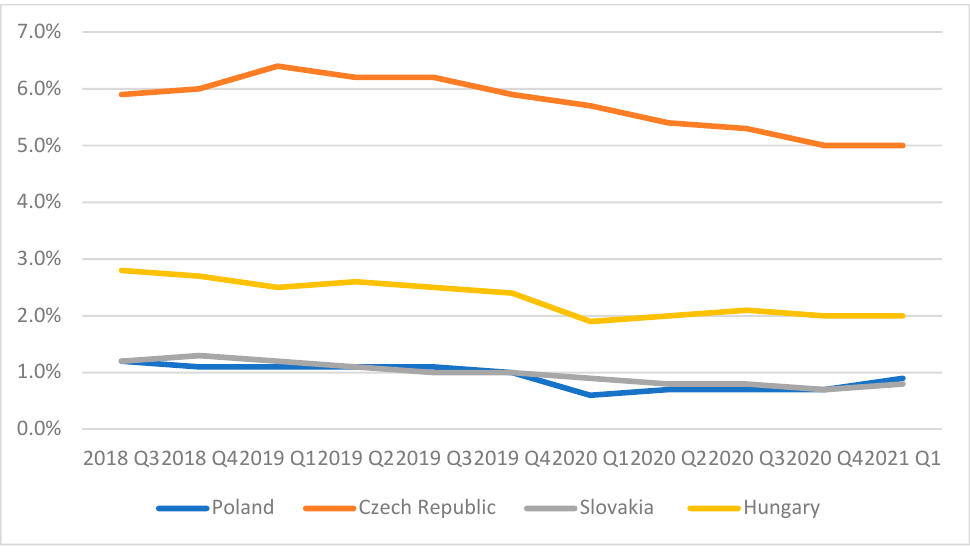
Figure 2 . Job vacancy rate in selected CEE countries . Source: (Eurostat Database 2021). Figure 2. Job vacancy rate in selected CEE countries. Source: (Eurostat Database